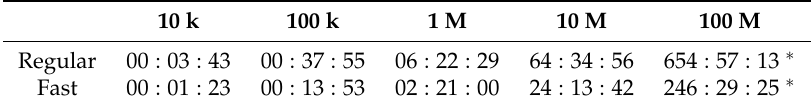
Table 2. Performance comparison between regular and fast SOM algorithms using a sequential approach executed in a single local machine (hh:mm:ss).